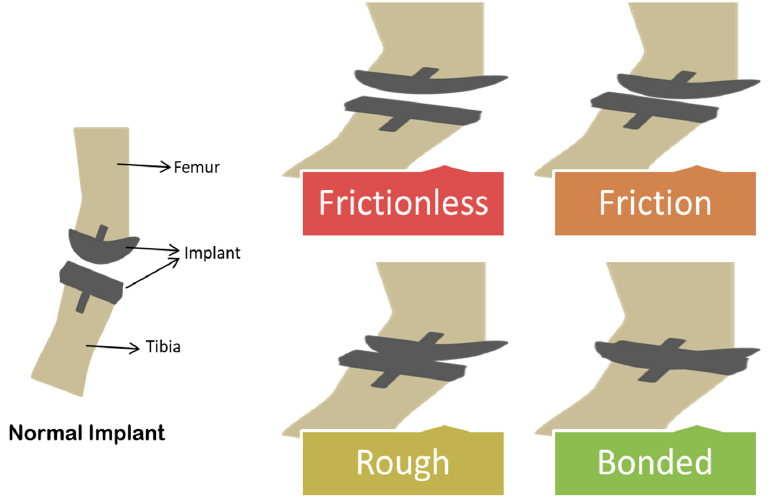
Figure 10. Diagrammatic representation of four kinds of frictional interference in the joint implant: frictionless, friction, rough, and bonded.